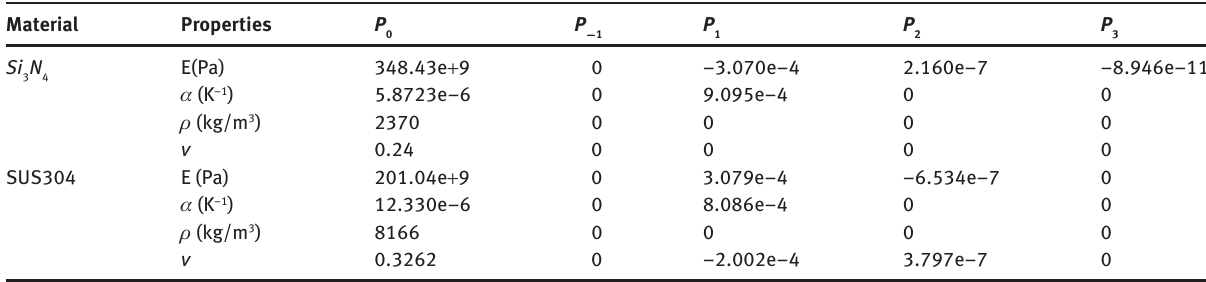
Table 4: Temperature dependent coefficients of Poisson’s ratio, mass density, thermal expansion coefficient and Young’s modulus for SUS304 and Si N . 3 4